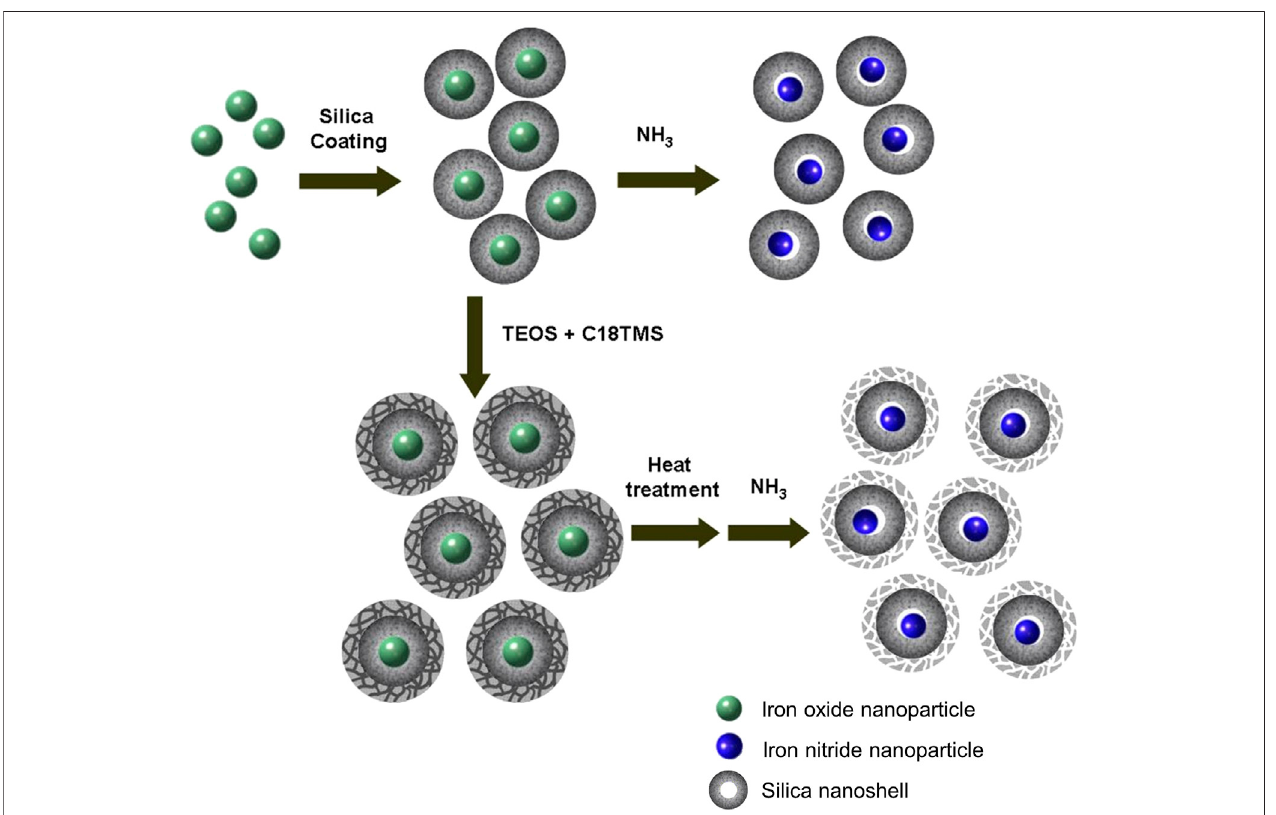
FIGURE 1 | Schematic illustration of the synthetic